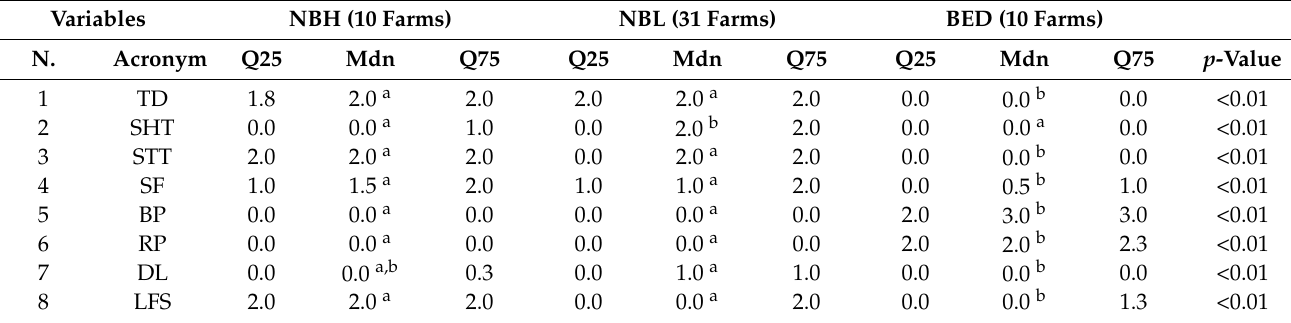
Table 4. Statistics for 8 ordinal variables.